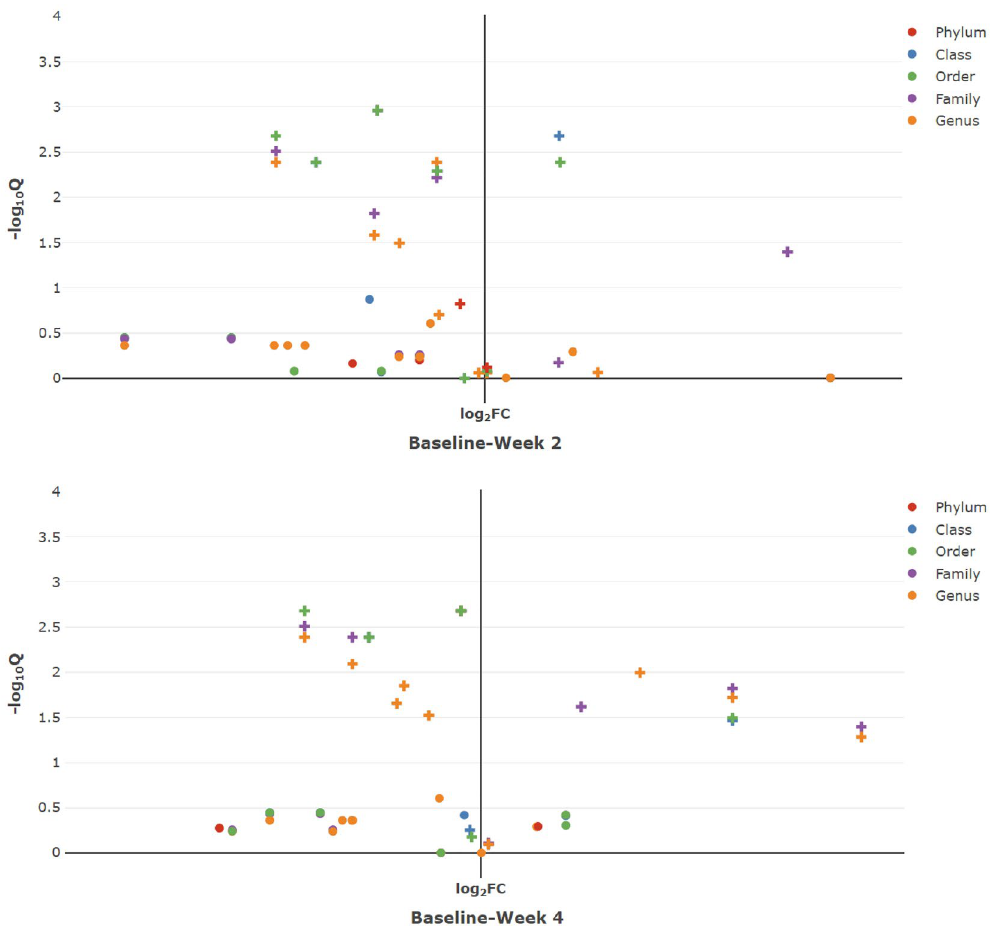
Figure 6. The volcano plot to overview the taxonomic differential abundances. Left: between the baseline group at the time of antibiotic administration and 2 weeks afterwards. Right: between the baseline group at the time of antibiotic administration and 4 weeks afterwards (right). x represents significantly differential